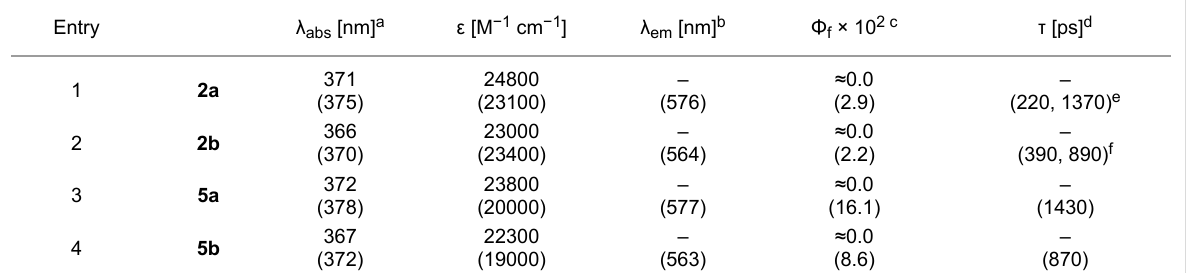
Table 1: Photophysical data for 2a , 2b , 5a , and 5b in benzene